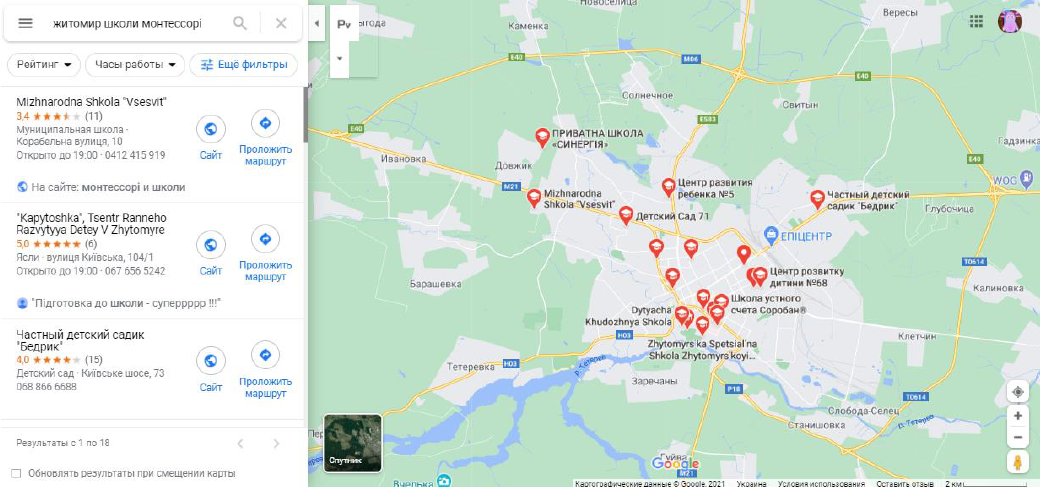
Figure 93: Presentation of paper